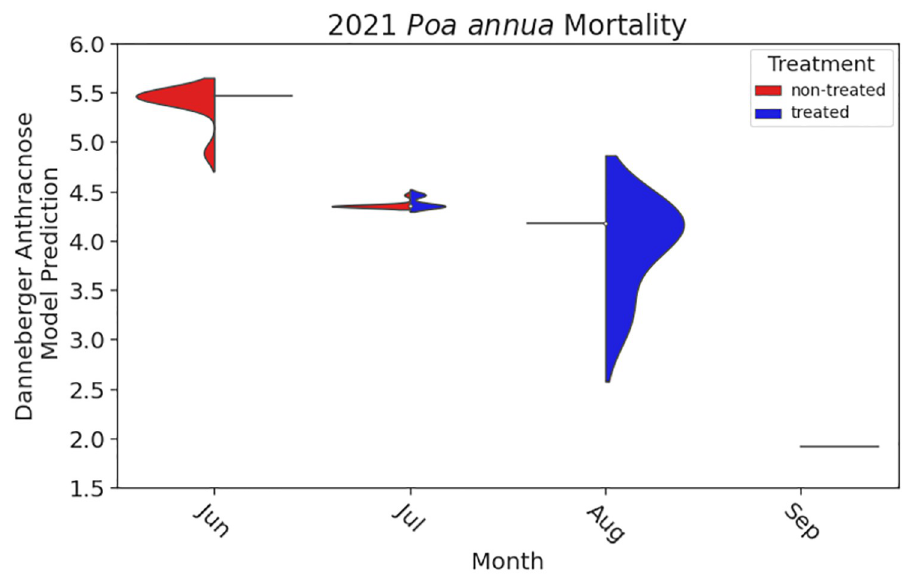
Fig 7. Poa annua mortality following either no fungicide treatment or fungicide treatment every 14 days from 27 May to 28 October 2021. The y-axis represents anthracnose ( Colletotrichum cereale ) severity index calculated using the Danneberger model [53], where an anthracnose severity index of 2 is the minimum conditions for infection. The x- axis represents time, indicated by month of year. Within each month, Poa annua mortality is split by fungicide treatment with vertical space equating to the range of anthracnose severity across the month and horizontal space equating to the smoothed number of senescence observations corresponding to each treatment. The figure was created in Python using ‘matplotlib’ (v. 3.5.0; https://matplotlib.org/) and seaborn (v. 0.11.2).